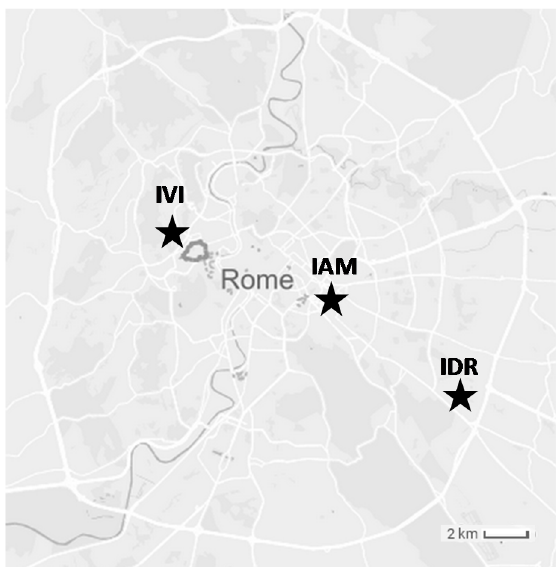
Figure 1. Location of the three schools under